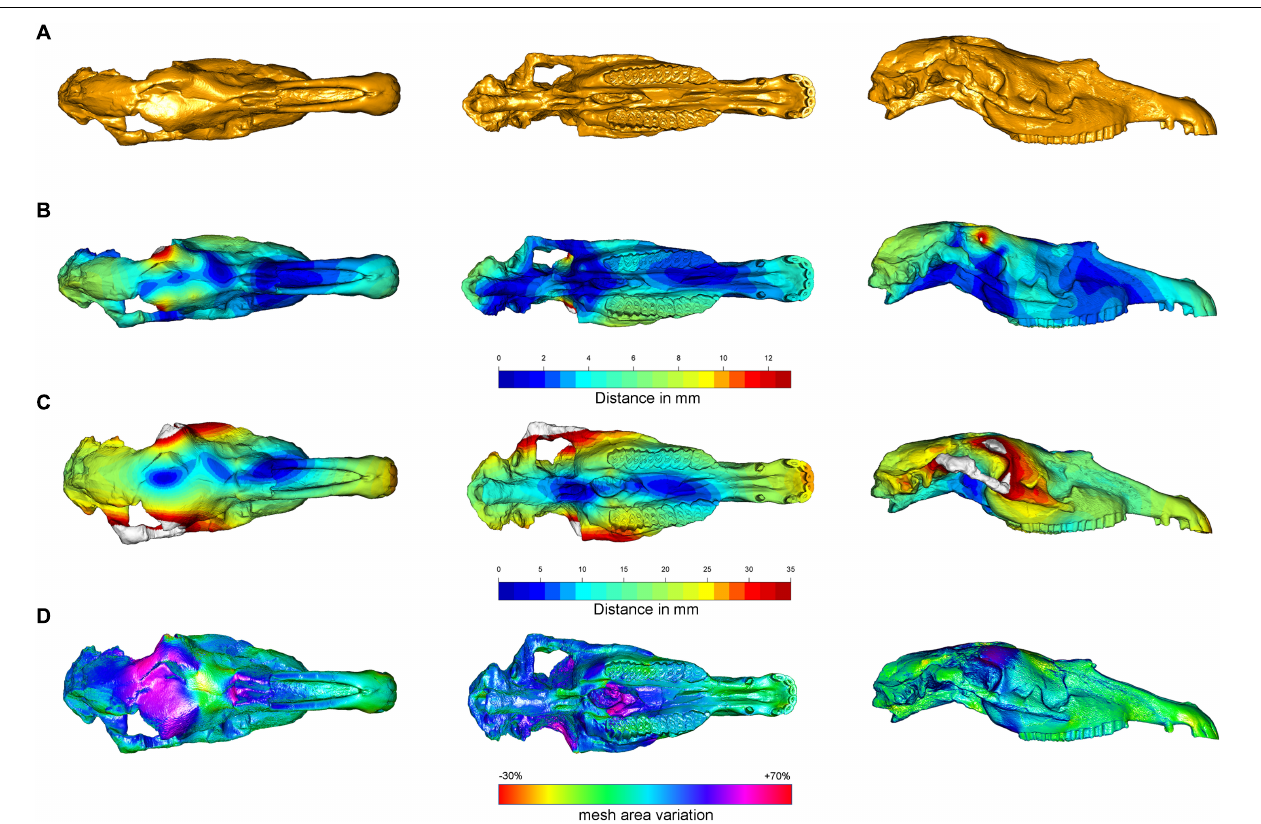
FIGURE 6 | Comparison of the 3D models obtained with the Target Deformation. (A) Represent IGF560. Color gradient (from blue to red) indicates the increase in mesh vertex displacement in millimeters in IGF560R (B) and IGF560W (C) . Panel (D) shows the mesh triangles area variation in terms of contraction (red/yellow) and expansion